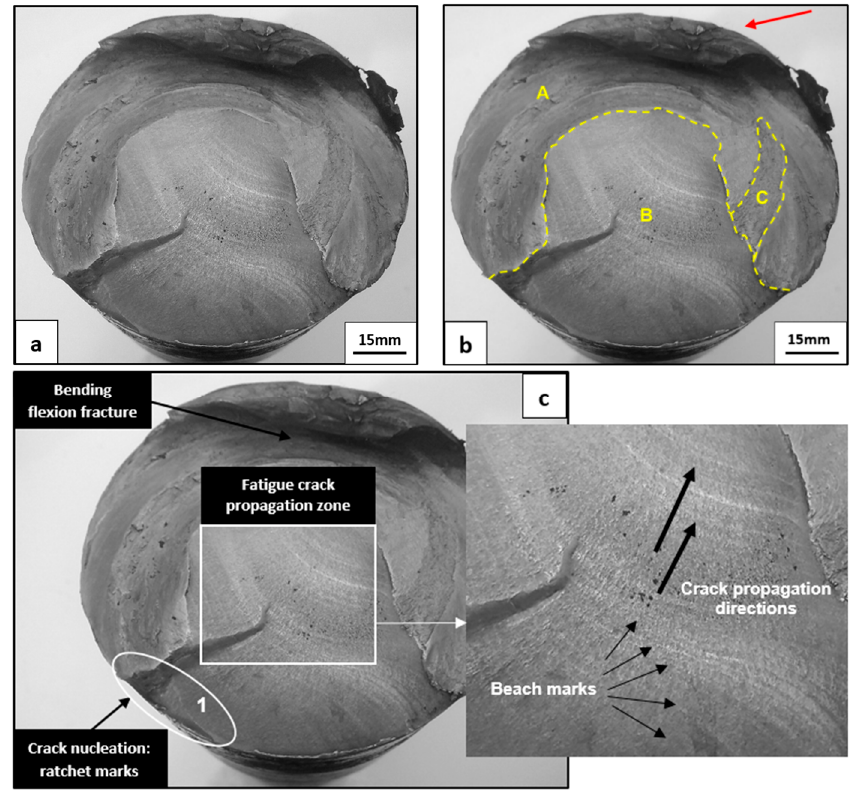
Figure 4. ( a ) Fracture surface after cleaning procedures; ( b ) zone of fatigue (region B) and the final failure area due to overload (A and C regions), red arrow indicates the final fracture zone; ( c ) fracture surface details of the reducer shaft.